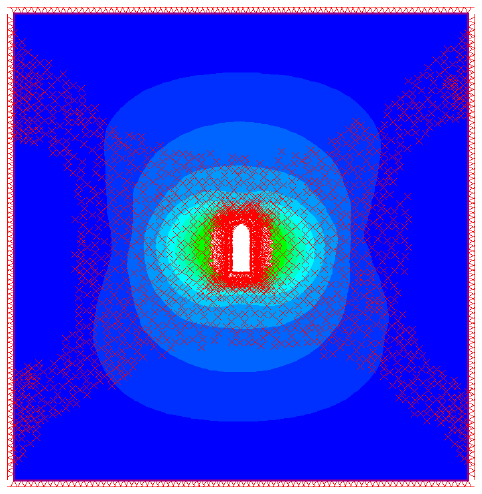
Figure 5. Tunnel model geometry and mesh discretization.